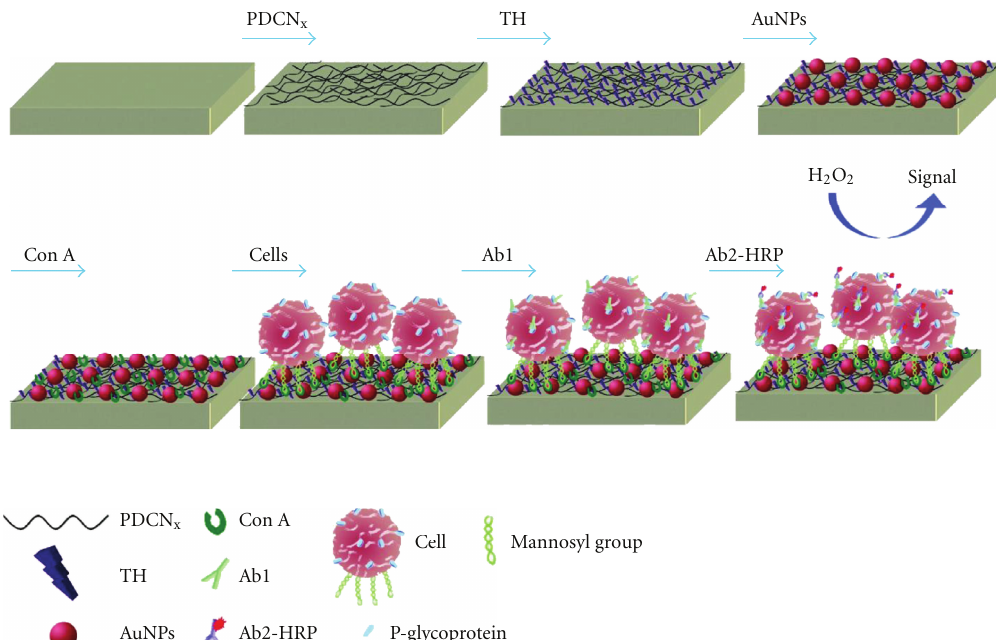
Figure 6: Schematic representation of the fabrication of the electrochemical enzyme-linked immunoassay for the detection of cell-surface glycans. Human epithelial carcinoma cells were captured on a glassy carbon electrode modified with nitrogen-doped carbon nanotubes, gold nanoparticles, and Con A. The enzyme HRP was incorporated to the electrode by two-step immunoreactions, and its catalytic reaction towards the oxidation of thionine by H 2 O 2 was monitored. Reprinted with permission from [54]. Copyright 2010 American Chemical